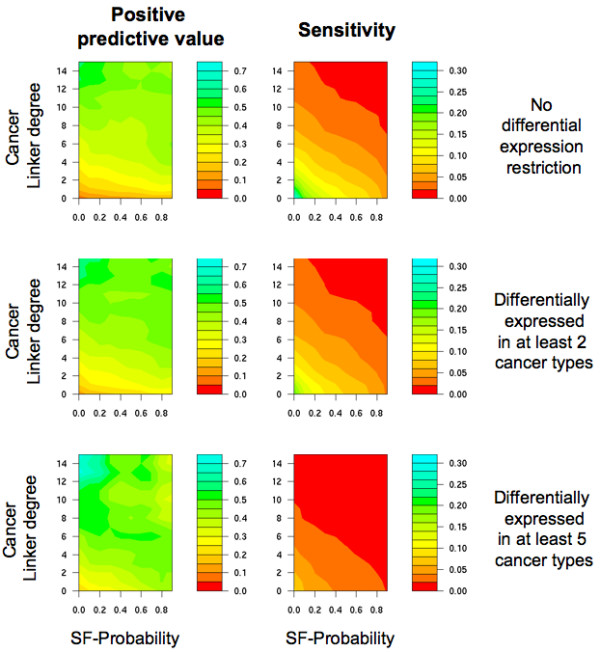
Contour maps for positive predictive value and sensitivity obtained when varying the thresholds applied by the integrative approach. In each of the following images, the x-axis is the SF-Probability threshold and the y-axis is the cancer linker degree (CLD) threshold. For a given restriction on the number of cancer types in which a gene must be differentially expressed in order to be considered a candidate (no restriction, at least two cancer types and at least 5 cancer types), the positive predictive value and sensitivity are provided for each combination of CLD and SF-Probability. Positive predictive values and sensitivities are shown using colored contour maps, from red (i.e. 0) to turquoise (i.e., 0.7 for positive predictive value and 0.3 for sensitivity). For example, imposing a gene to be differentially expressed in at least two cancer types, with a CLD of 6 and with an SF-Probability of 0.4, the positive predictive value is 0.4 for sensitivity of 0.05.